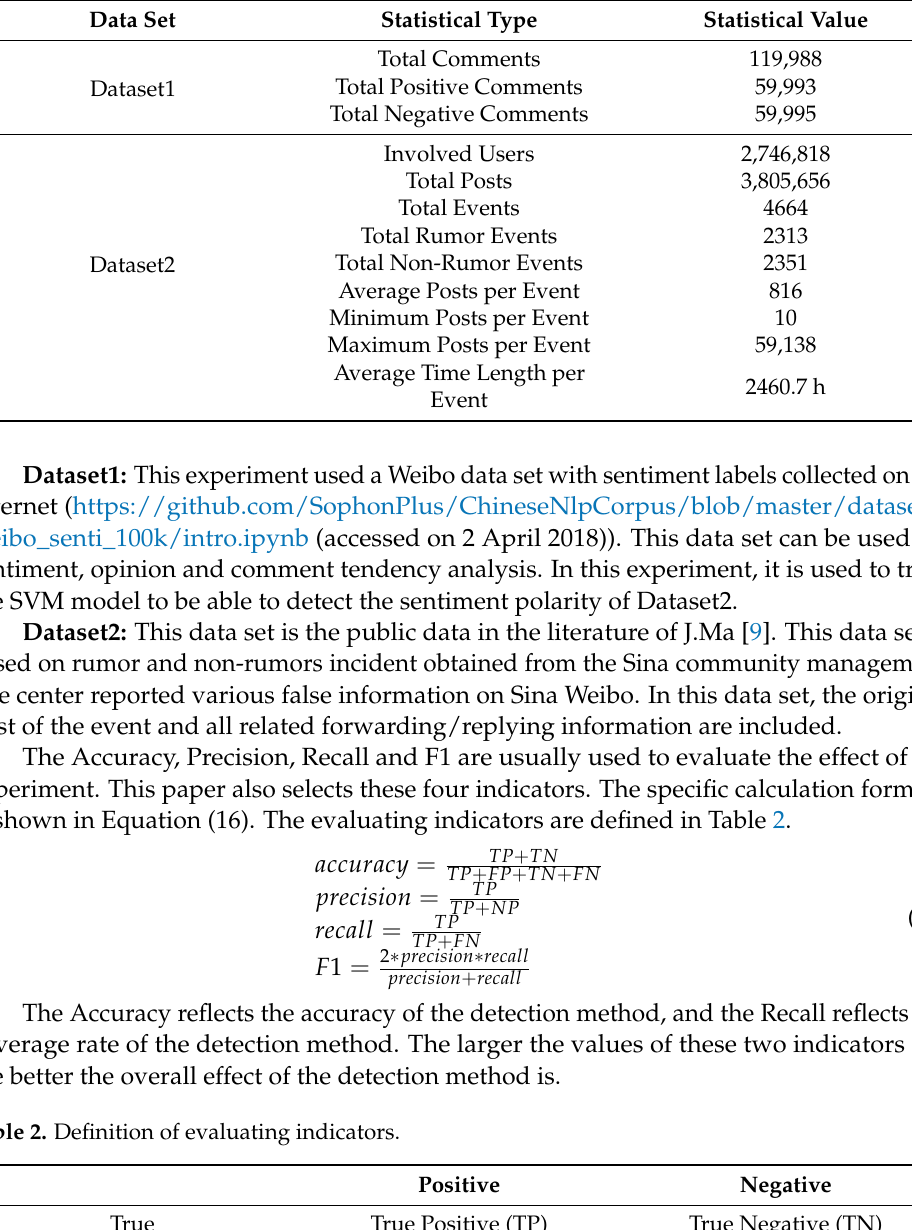
Table 1. Statistics of the rumor events dataset and sentiment polarity data.